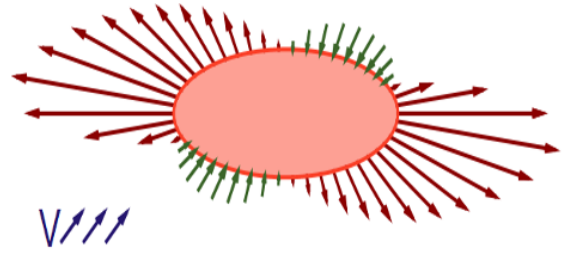
Fig. 9. The distribution of the pressure coefficient on the surface of an elliptical cylinder, Γ =